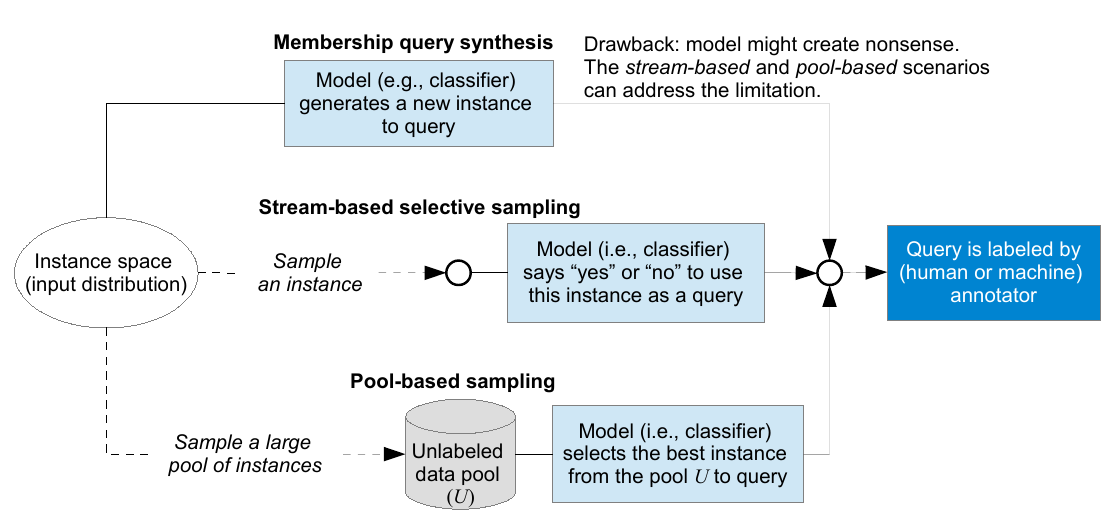
Figure 4. An illustration of the three main active learning scenarios (adapted based on [26]). Each starts from the set of all possible observations (the instance space at left) and applies a query strategy (light blue box) for selecting which instance to ask the human or machine annotator to label (dark blue box). Membership query synthesis was proposed in [45], and further developed and extended in